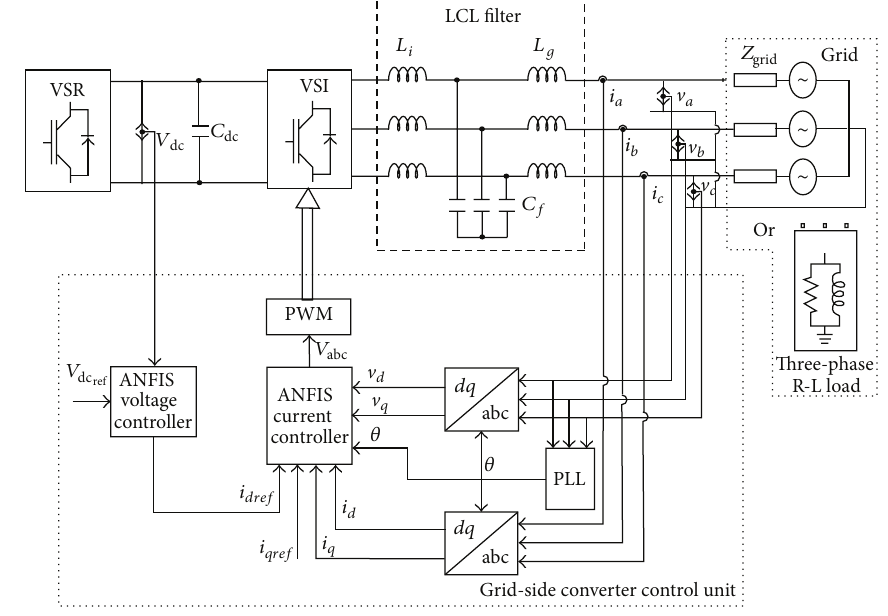
Figure 3: Detailed block diagram of the grid or load-side converter control.